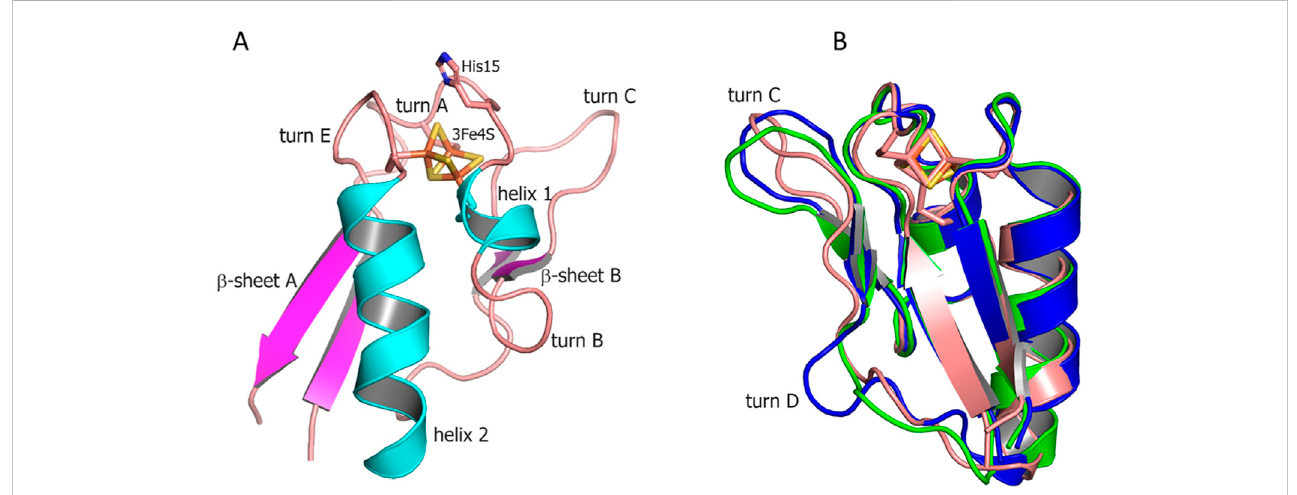
FIGURE 1 (A) Overall structure of Fdx ferredoxin of M. tuberculosis . (B) Structural alignment of Fdx (salmon) with other structurally characterized 3Fe – 4S ferredoxins from R. palustris HaA2 (PDB: 4OV1; blue) and P. furiosus (PDB: 1SJ1; green). The Fe – S clusters are shown in stick representation (Fe, orange; S,